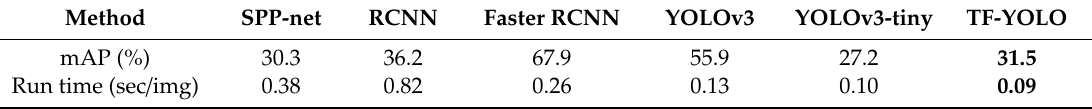
Table 4. Comparison of precision and speed for region-based proposal methods on VOC 2007 dataset.